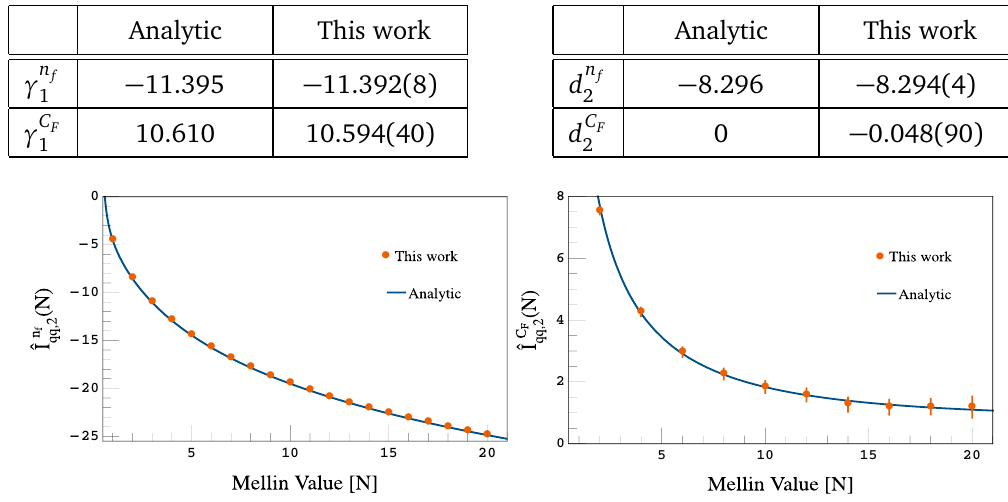
Figure 2: Comparison of the two-loop non-logarithmic contribution to the quark-to- quark matching kernel for p resummation against the analytic results of [ 20,21 ] T